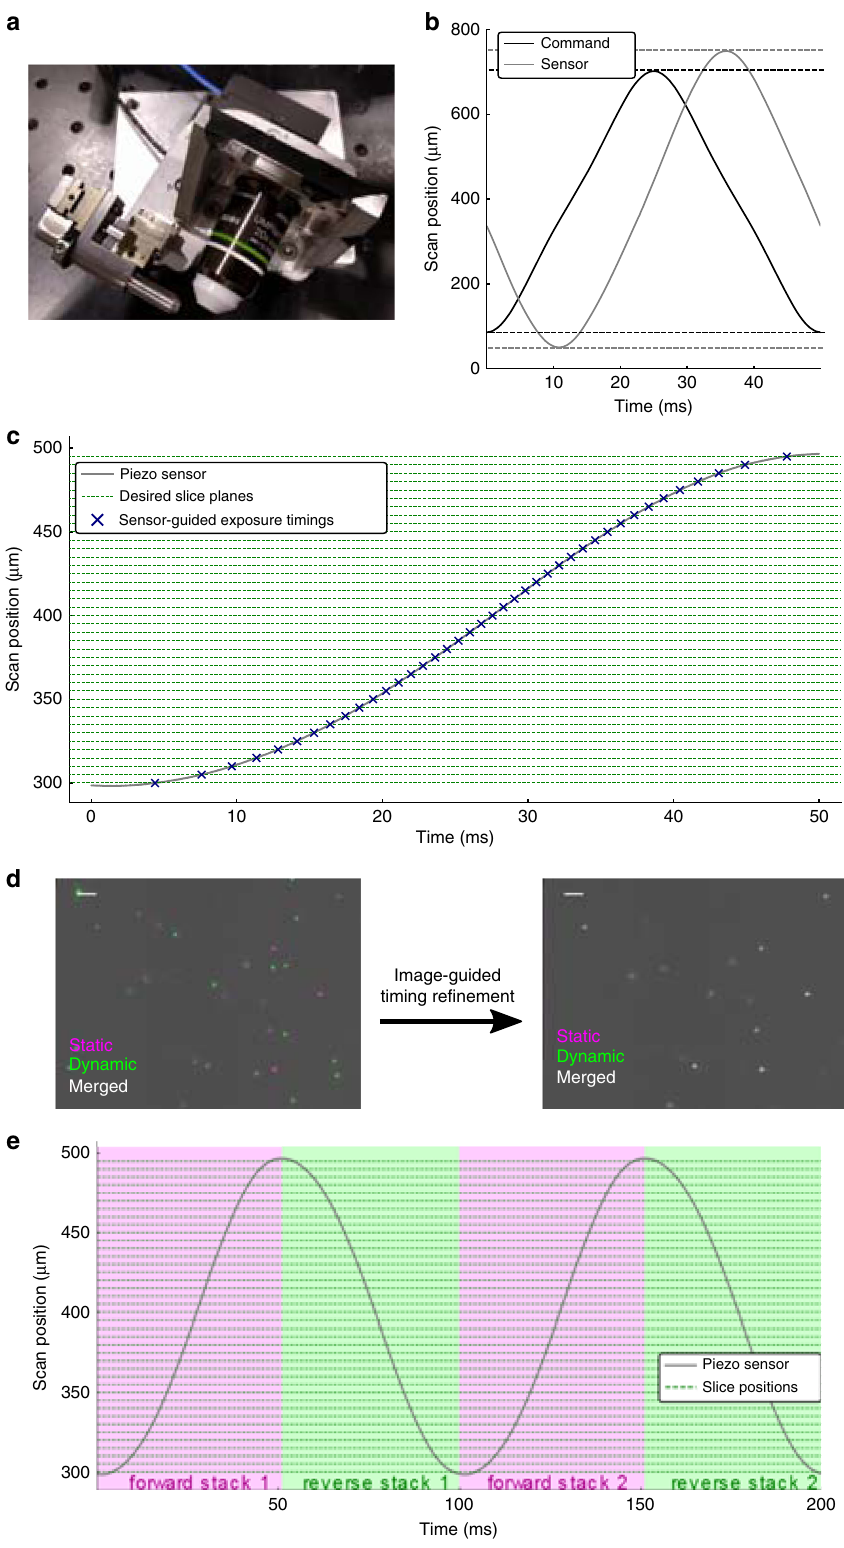
piezo sensor value and the true focal plane position was predicted by the acceleration of the scan system, suggesting that the error may be related to mechanical forces acting on the system (Sup- plementary Fig.